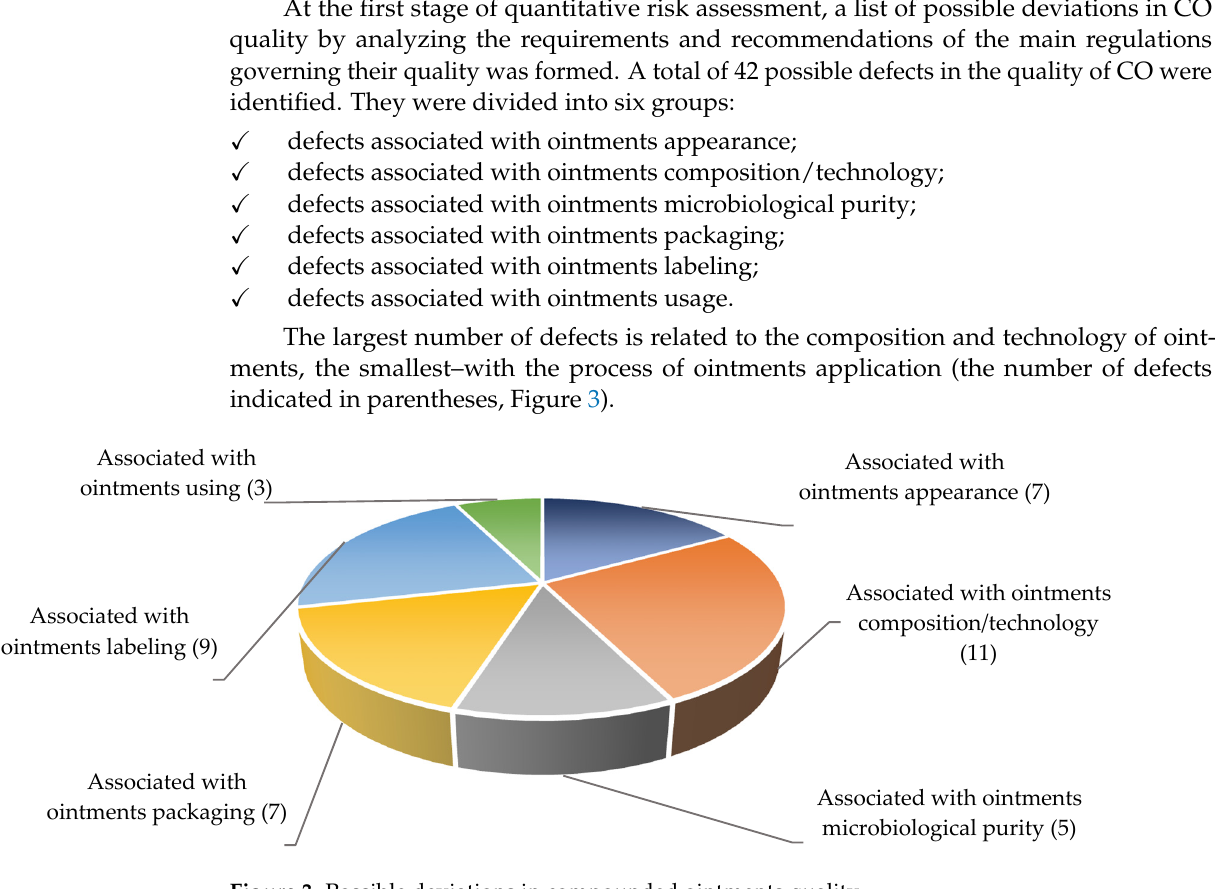
Table 1. Characteristics of respondents who participated in the survey. Respondent